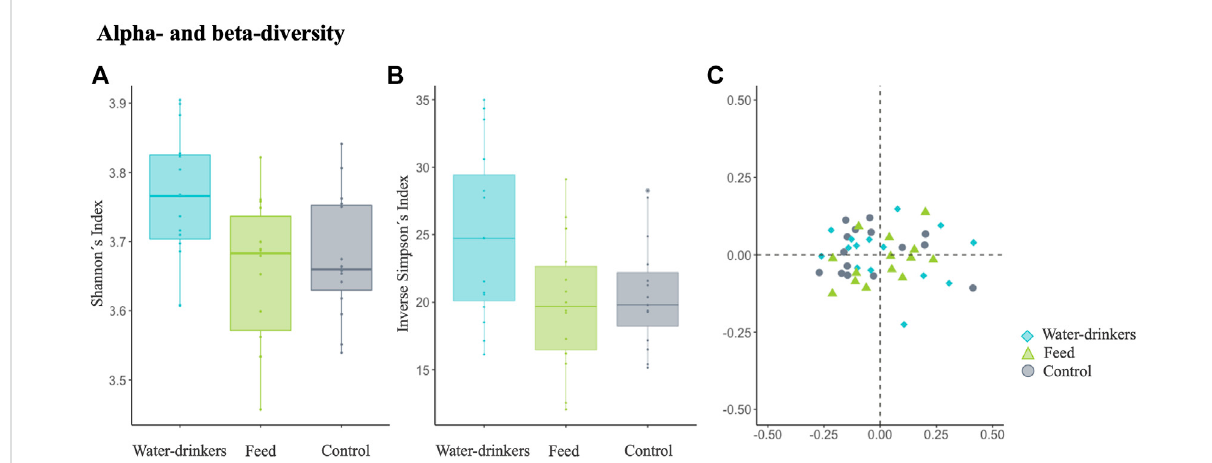
FIGURE 3 Examining the effects of Salmonella phage on the caecal microbiota in Salmonella -free broilers. Caecal microbiota composition dissimilarity through the representation of the and alpha- and beta diversity scores from water, feed and control groups. The alpha- and beta diversity scores were calculated with the additive log-ratio of each species abundance according to a reference genus ( Anaerofustis ). Alpha diversity was computed using (A) Shannon ’ s H index and (B) Inverse Simpson index. Beta diversity was computed by calculating (C) the Bray-Curtis dissimilarity matrix. Differences among populations were established with a p-value ≤ 0.05. The water group (blue) received a 10 8 PFU/ml phage concentration via drinking water. The feedgroup (green)received a 10 8 PFU/g phage concentration via feed (encapsulated).The control (grey) group didnot receive a